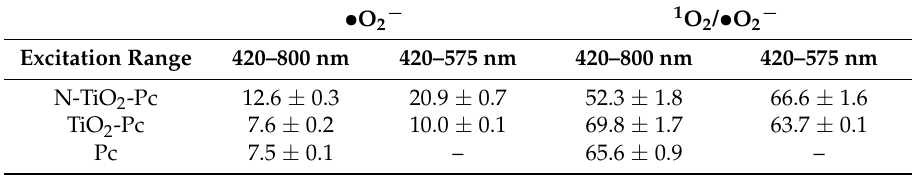
Table 1. Specific ROS percentage (%) of total ROS under different irradiation wavelengths.